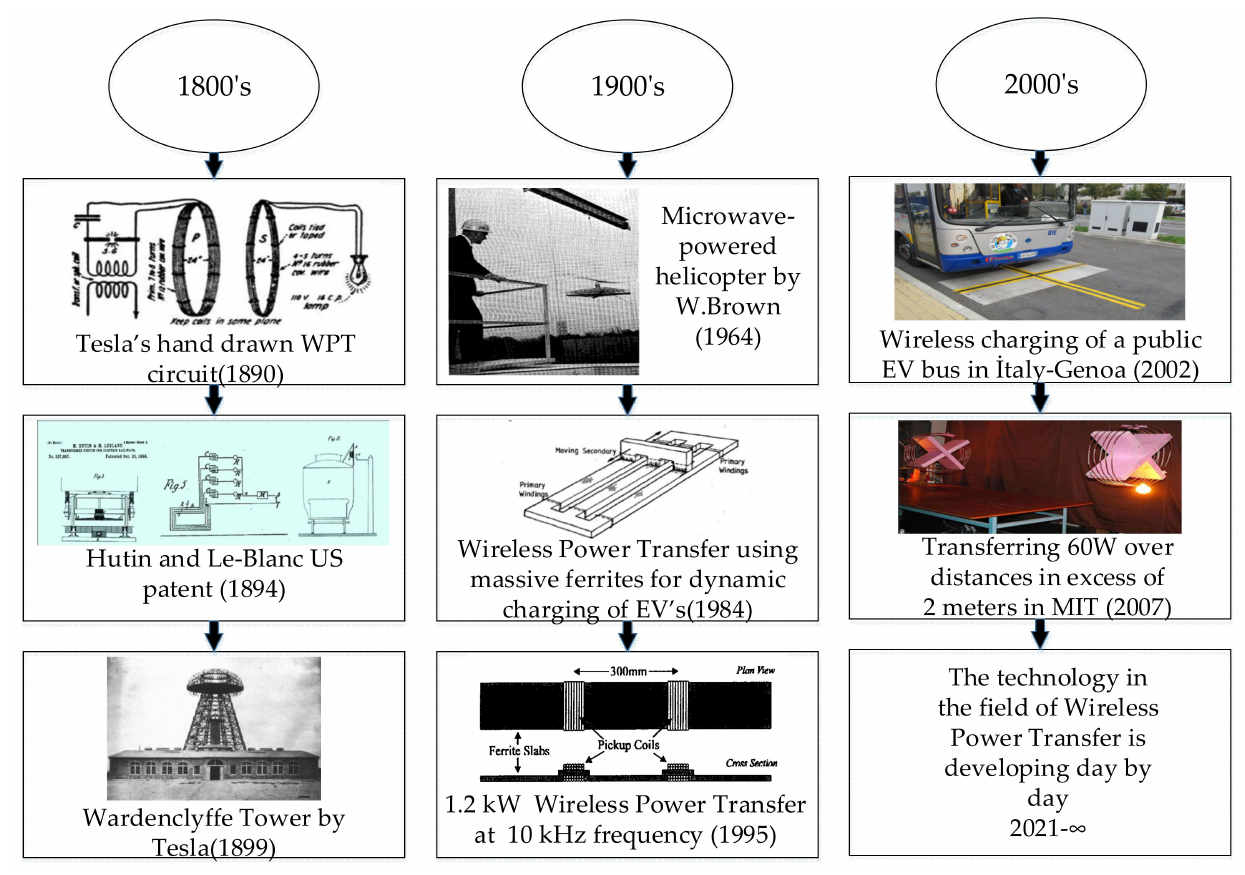
Figure 2. History of evolution of WPT